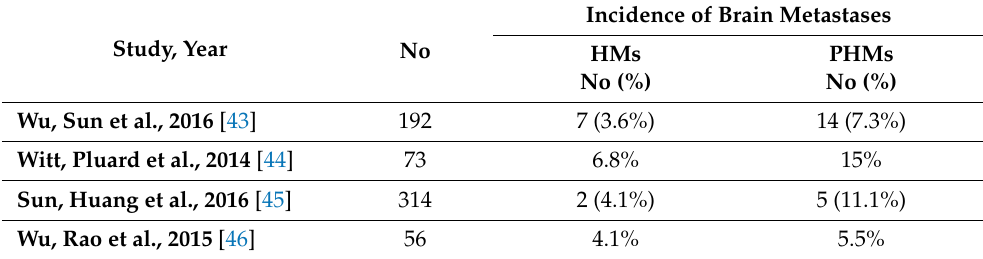
Table 6. The incidence of hippocampal and perihippocampal metastases in breast cancer patients estimated by Han, Cai et al.